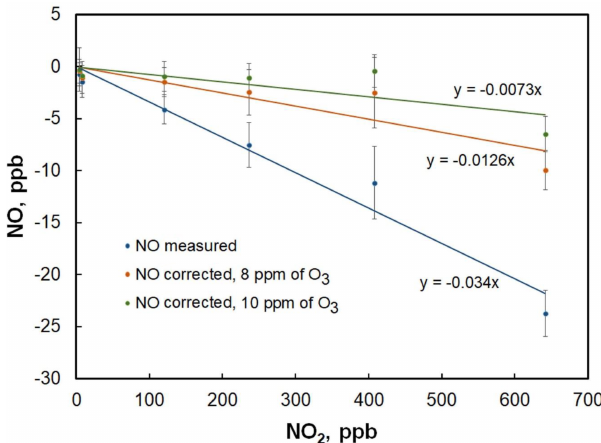
Figure 6. Plot of the NO measured in the folded tubular photometer vs. NO 2 mixing ratio. The blue line is a linear fit to the data points and yields a slope of − 3.4ppb NO / 100ppb of NO 2 . Corrected NO concentrations after application of Eq. (6) yield the orange and green points using O 3 concentrations of 8 and 10ppm, respectively. Slopes decrease to − 1.3ppb NO / 100ppb of NO 2 and − 0.7ppb NO / 100ppb NO 2 for the 8 and 10ppm cases,